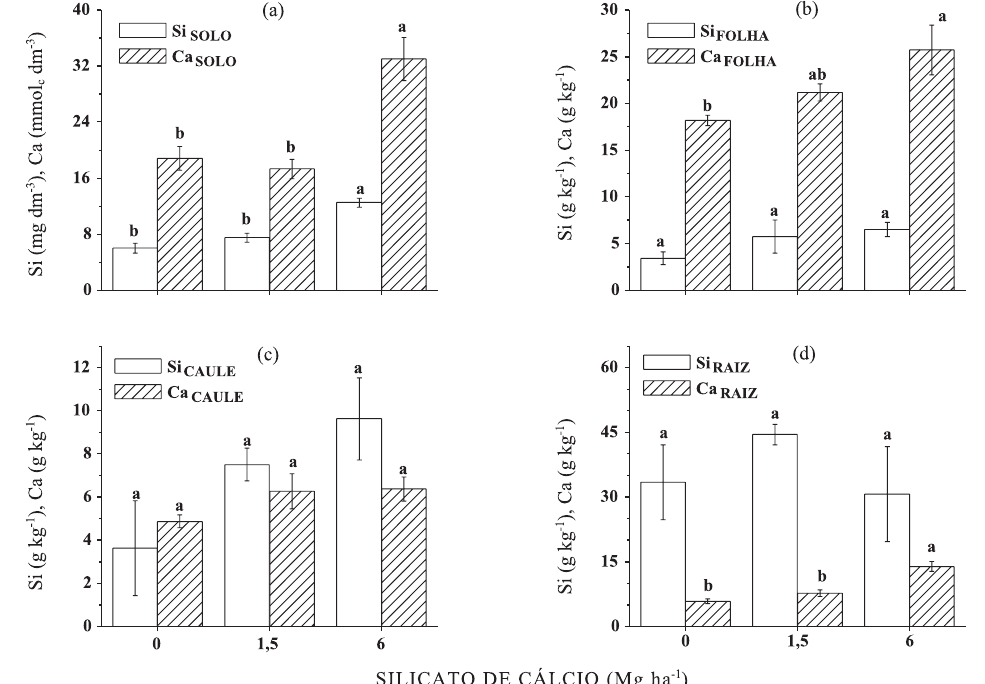
Figura 1. Variação do teor de cálcio e silício no solo (a), nas folhas (b), no caule (c) e nas raízes (d) de cafeeiros após 130 dias da adubação silicatada. Cada símbolo representa o valor médio de três (b-d) ou quatro (a) repetições (± erro-padrão). Letras distintas entre tratamentos indicam diferença estatística pelo teste de Tukey (p <